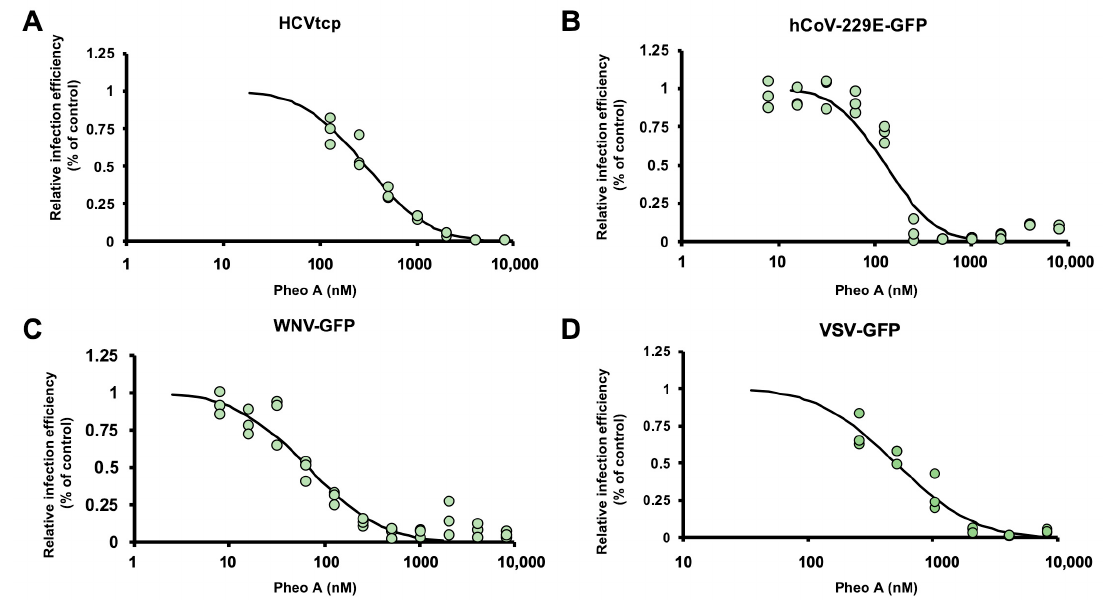
Figure 5. Antiviral spectrum of PheoA against different RNA viruses. The effectiveness of PheoA was tested against four different recombinant RNA viruses expressing reporter genes. ( A ) Huh7 cells were infected with HCVtcp in the presence of increasing PheoA doses and luciferase activity was determined 48 h post-inoculation. ( B – D ) Cells were inoculated in the presence of increasing concentrations of PheoA at MOI 0.01 and incubated to enable virus propagation. At the endpoint, cells were fixed and counter stained with DAPI to control for unexpected cytotoxic effects. Relative infection efficiency was estimated using automated microscopy and is expressed as percentage of the infection efficiency observed in control wells. ( B ) Huh7 cells were infected with hCoV-229E-GFP and fixed 48 h post-inoculation. ( C ) Huh7 cells were infected with WNV-GFP and fixed 48 h post-inoculation. ( D ) A549-ACE2 cells were inoculated with VSV-GFP and fixed 16 h post-inoculation. Individual replicate data are shown as green dots ( n = 3) and the PROBIT regression curve used to estimate EC50 values is